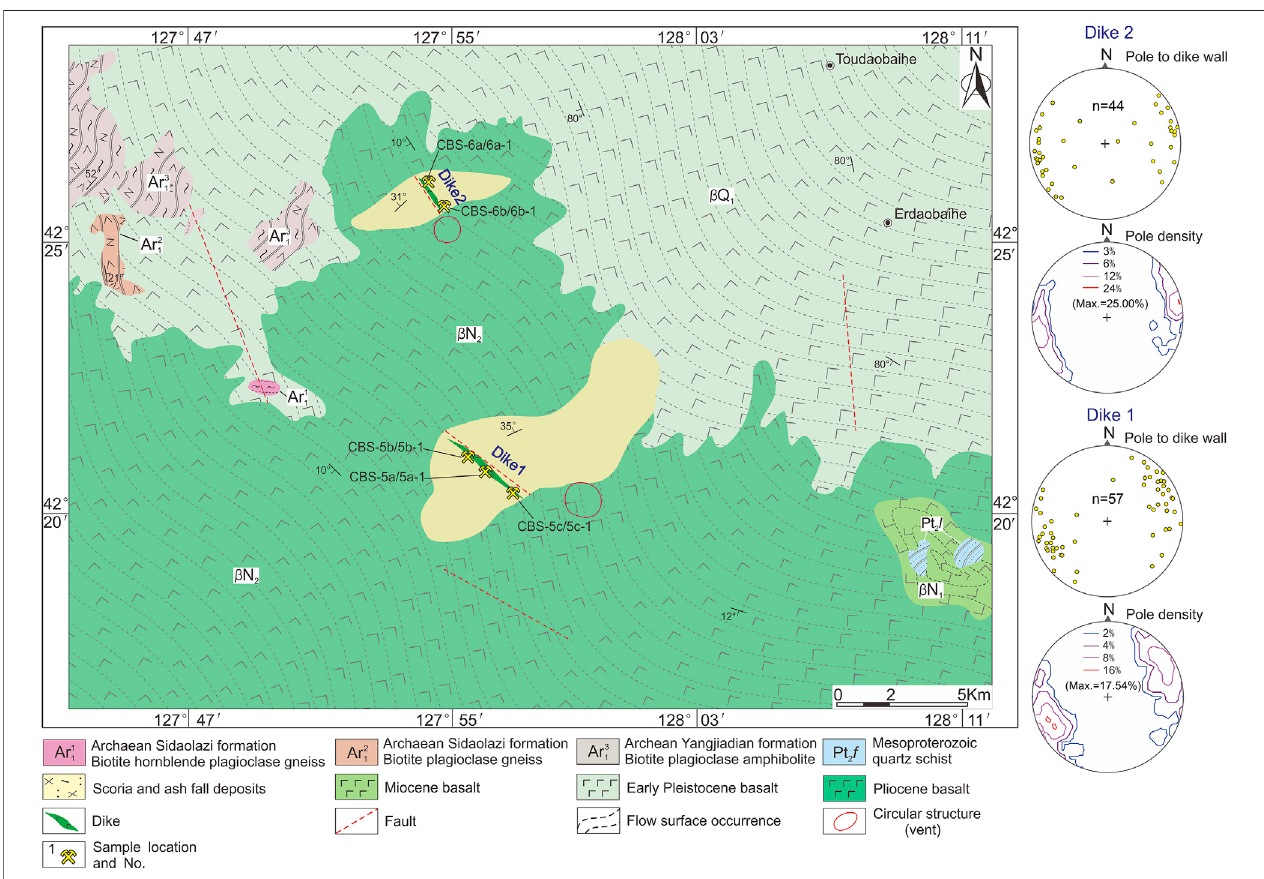
FIGURE2| Geologicalsketchmapofthestudyregion(afterBGMRJP,1988)withthelocationofthemonogeneticventsandofthecollectedsamples.Ontheright, the measured poles to the dike walls in Dike 1 and Dike 2 are shown. Density contours of the poles are also reported.